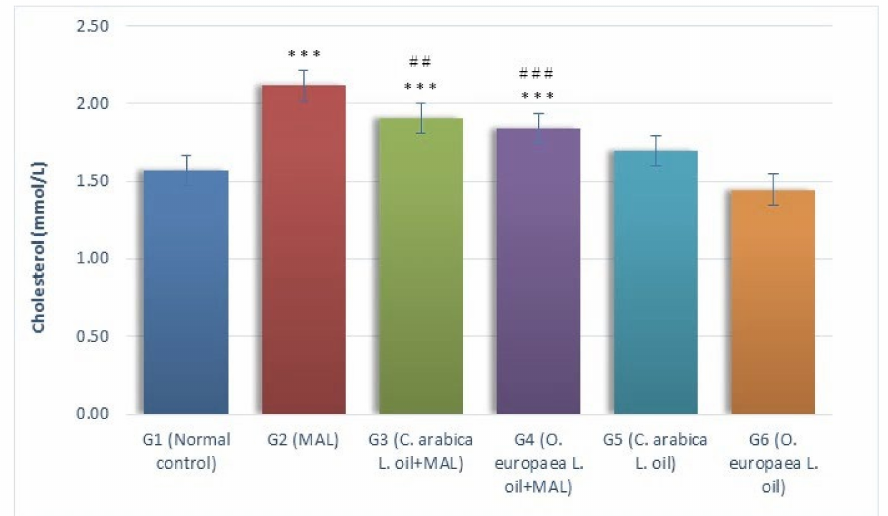
Figure 2. Influence of Coffea arabica L. oil and Olea europaea L. oil on the level of cholesterol. When a comparison was made against the normal control group, a significant difference was found in the mean values at p ≤ 0.001 ***. When a comparison was made against the MAL-intoxicated group, a significant difference was found in the mean values at p ≤ 0.01 ## ; p ≤ 0.001 ###